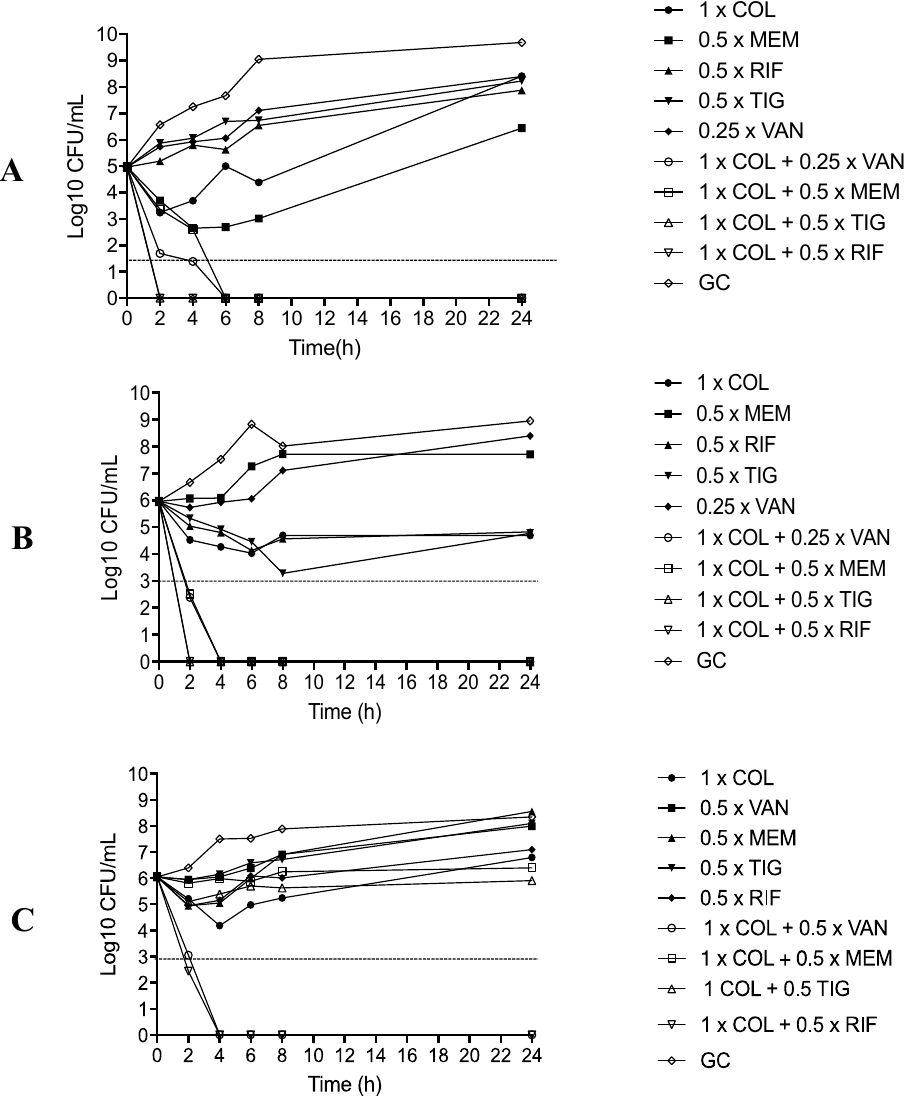
Figure 2. Killing studies of COL-containing combinations against COL-S (1A), COL-LR (1B) and COL-HR (1C) CR-Ab strains. COL: colistin; VAN: vancomycin; MEM: meropenem; TIG: tigecycline; RIF: rifampin; GC: growth control. Dashed line represents bactericidal activity that occurred at any time point compared to the initial bacterial inoculum. [17–20].